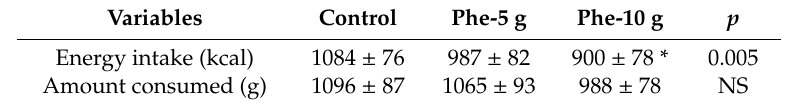
1 Data are means ± SEMs. n = 16. NS, not significant. Data were analysed using repeated-measures one-way ANOVA with treatment as a factor. Post-hoc comparisons, adjusted for multiple comparisons by Bonferroni’s